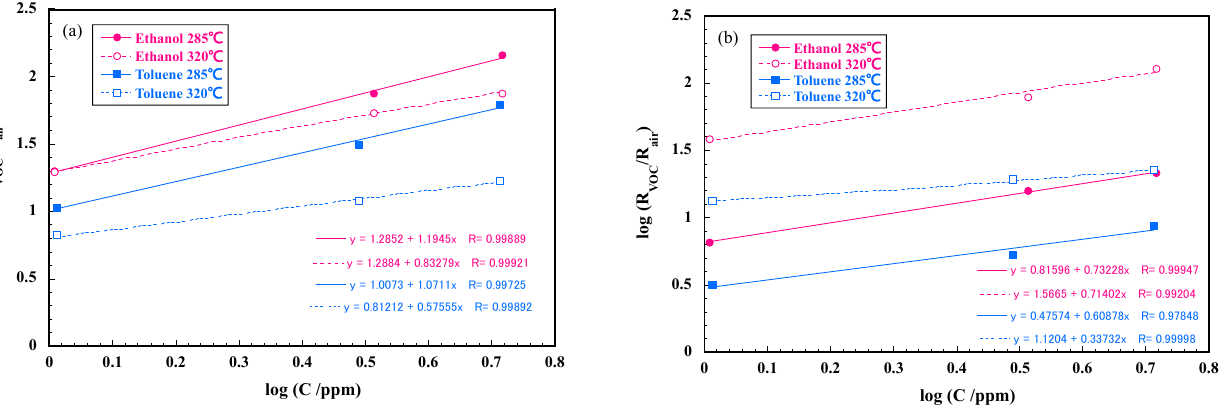
Figure 9. Log-log plots of concentration of ethanol and toluene vs. sensor responses at 285 and 320 °C with sample A ( a ) and sample B ( b ). Table 1. Characteristic parameters of a and n assuming R VOC / R air = aP n for the sensors with samples A and B.